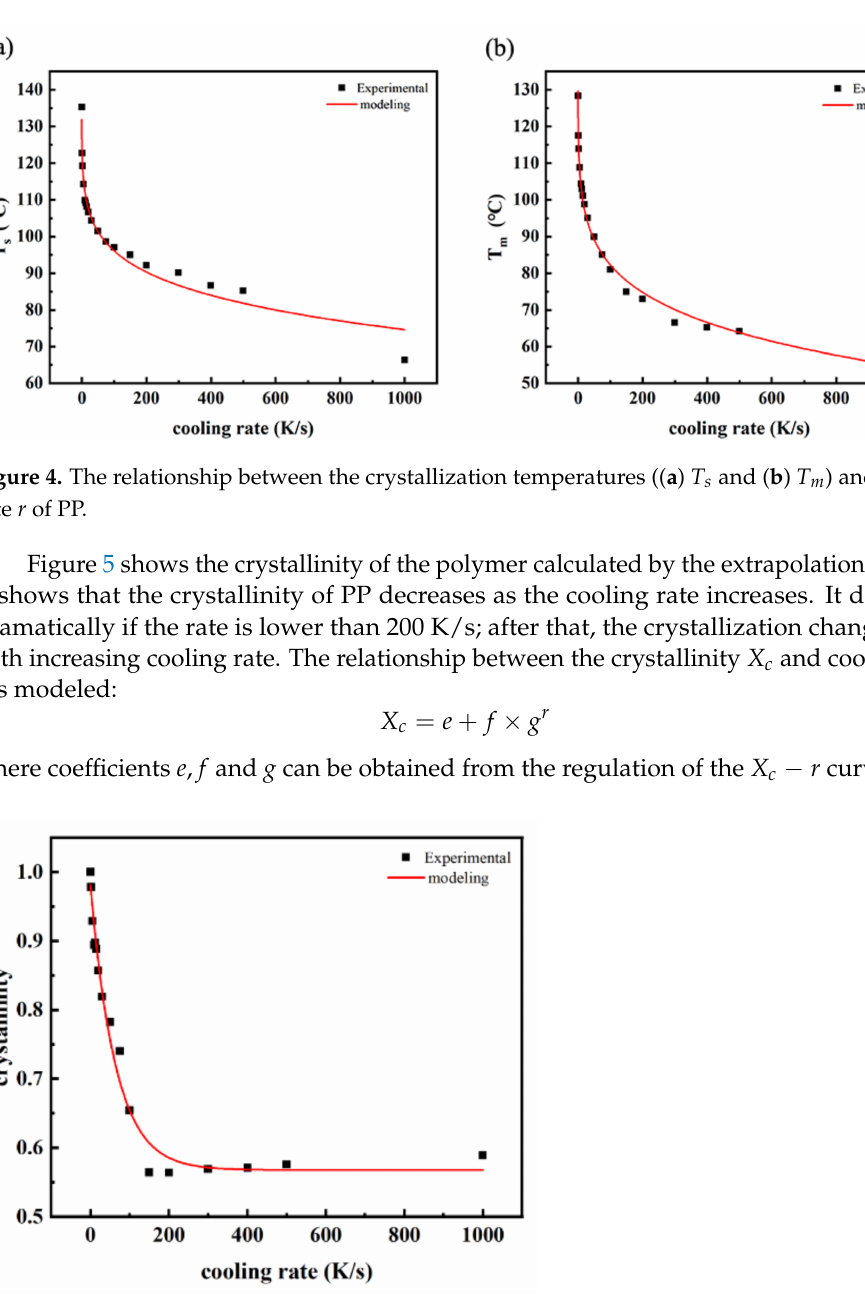
Figure 5. The relationship between crystallinity and cooling rate of